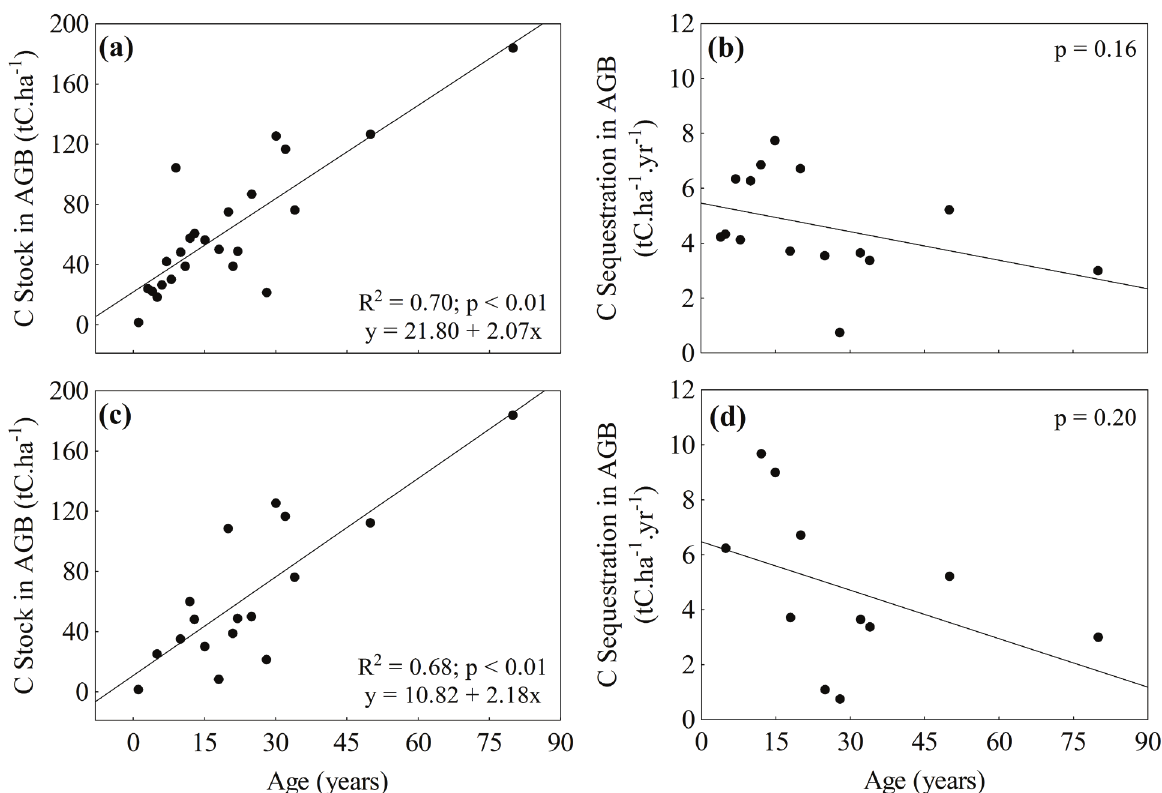
Figure 6 - Regression between carbon stock and sequestration in the aboveground biomass (AGB) and the age of the forests, including data from plantations and managed forests ( a-b ) and excluding these data ( c-d